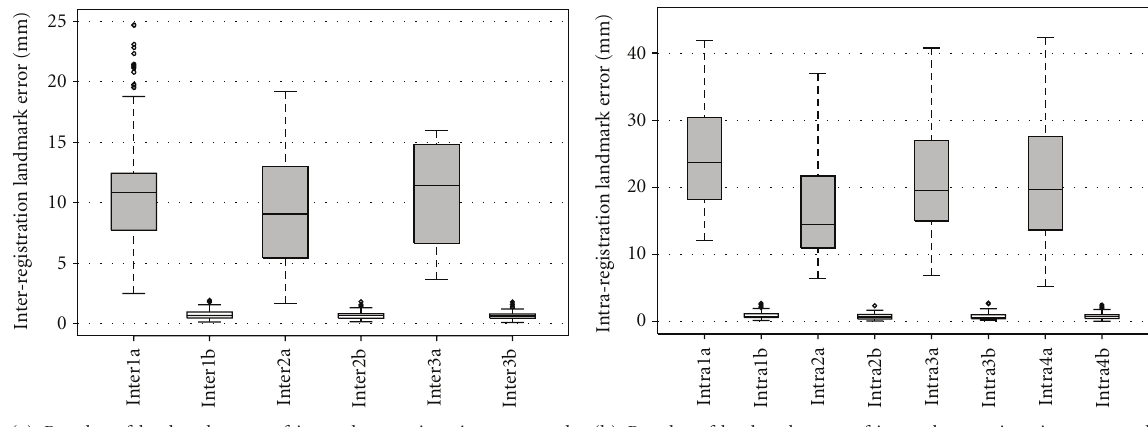
(a) Boxplot of landmark error of inter-phase registrations averaged (b) Boxplot of landmark error of intra-phase registrations averaged over six subjects Figure 7: Registration accuracy on airway landmarks. (a) Boxplot of landmark error of interphase registrations. Inter1a, Inter2a and Inter3a denote the error from post0TLC, post4TLC, and post24 TLC to baseTLC before registration, respectively. While Inter1b, Inter2b and Inter3b denote the error after three interphase registrations. (b) Boxplot of landmark error of intraphase registrations. Intra1a, Intra2a, Intra3a, and Intra4a denote the error from baseFRC to baseTLC, from post0FRC to post0TLC, from post4FRC to post4TLC, and from post24FRC to post24TLC before registration, respectively. While Intra1b, Intra2b, Intra3b and Inter4b denote the error after four intraphase registrations.